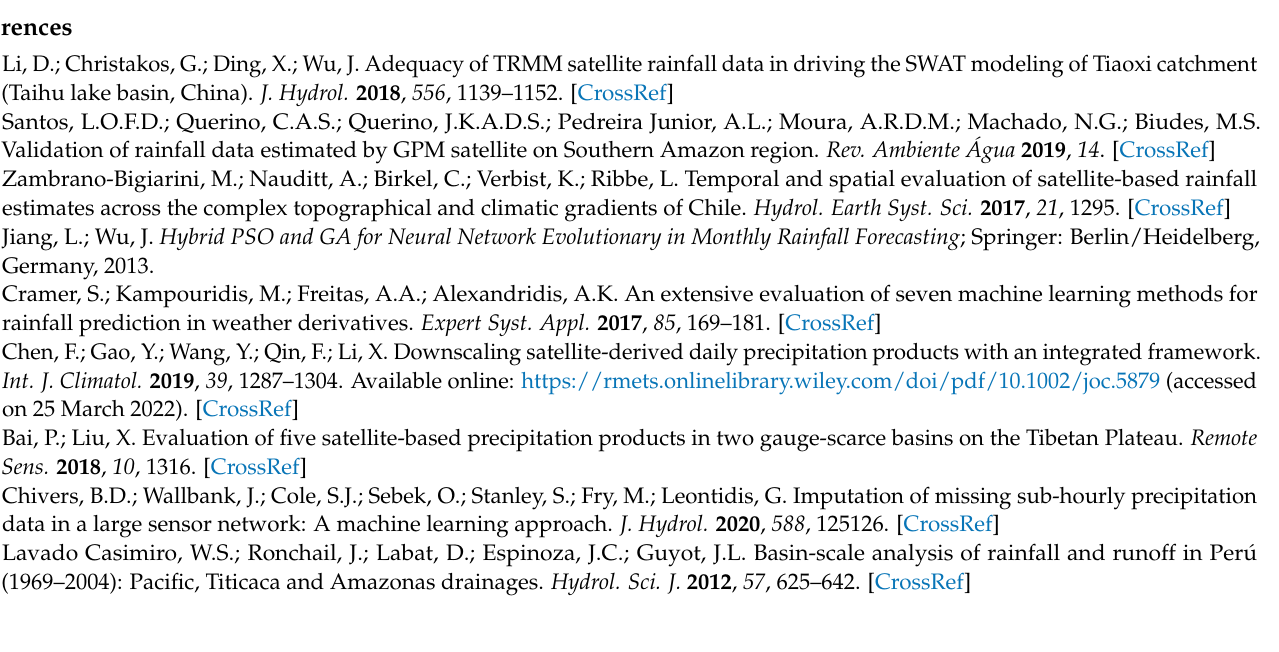
S2: Annual regional vector indices—Region 4; Table S3: K-means clustering (2001–2019 period); Table S4: Correlation coefficient—Region 2; Table S5: Correlation coefficient—Region 4; Table S6: Model efficiency according to fit statistics—Region 2; Table S7: Model efficiency according to fit statistics—Region